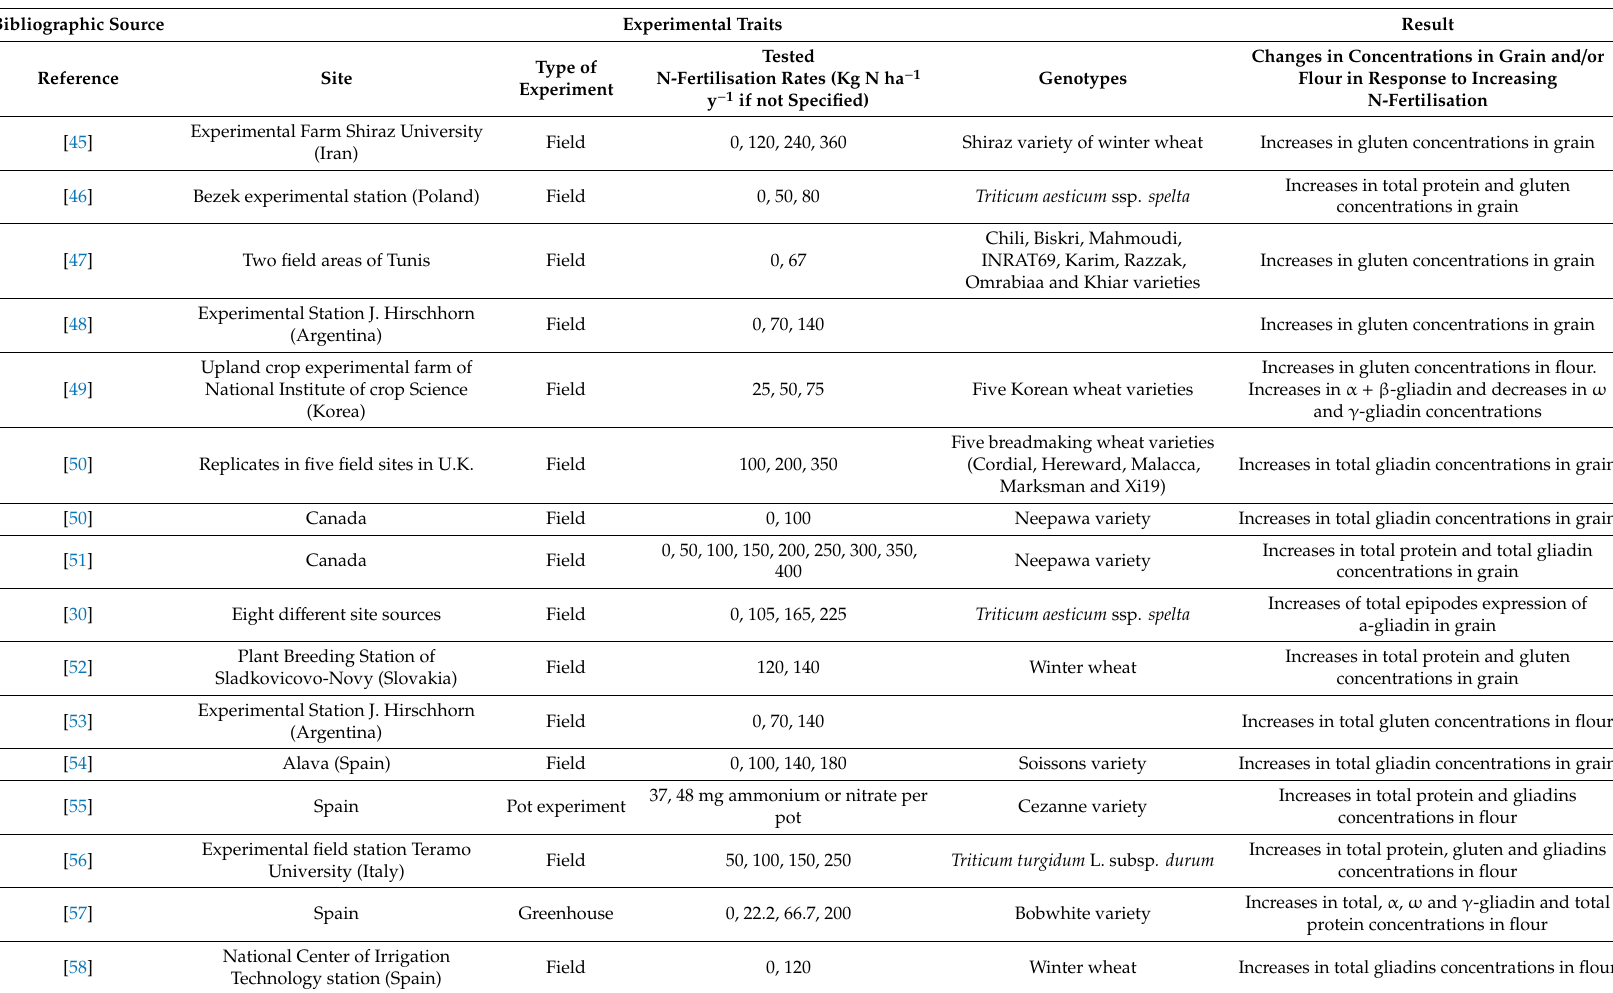
Table 1. Responses of the concentrations of total gluten, total gliadins, α / β -gliadins, γ -gliadins and ω -gliadins and gliadin transcripts in wheat grains after an experimental increase in N fertilisation